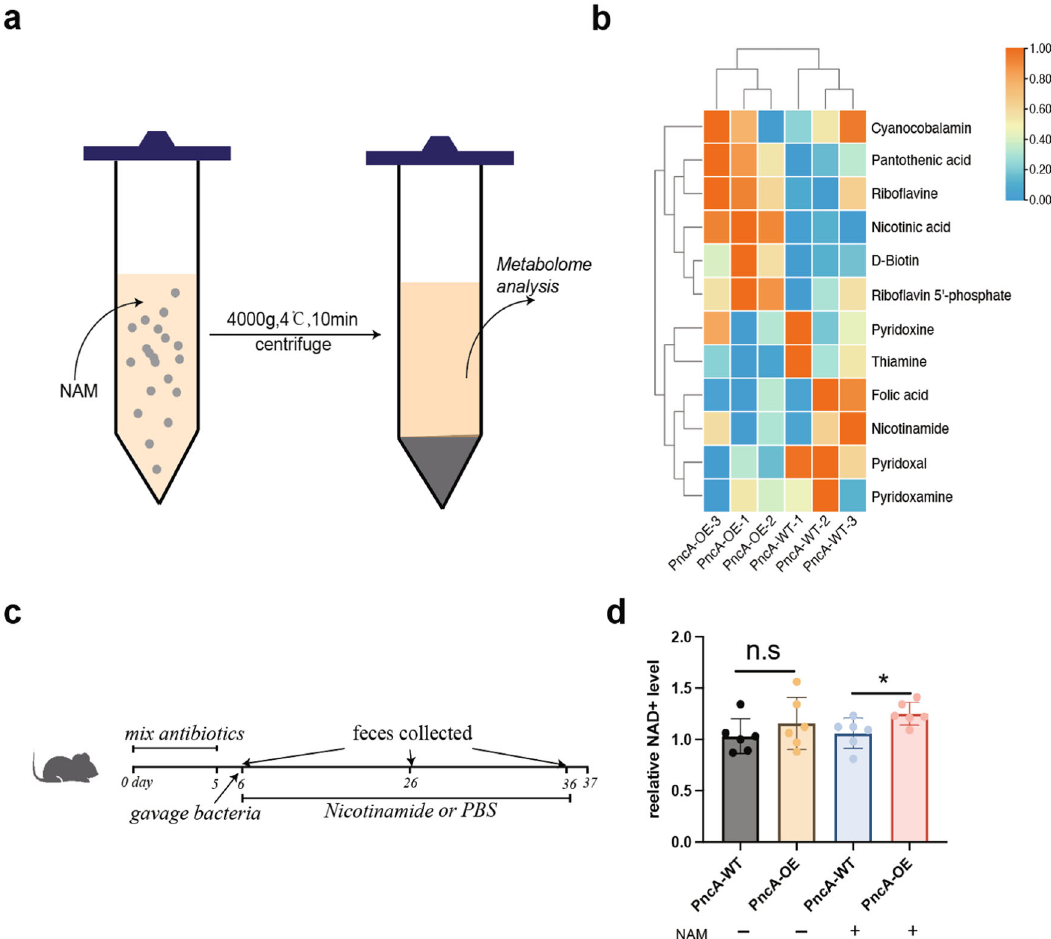
Fig. 3 PncA-overexpressing E. coli affect host liver NAD metabolism. a Schematic diagram of the in vitro experiment (created by Adobe Illustrator). b Heatmap of the metabolites in the bacterial culture medium. c Schematic diagram of the mouse experiment. d Liver NAD + level after colonizing mice with different genotypes of E. coli ( n = 6, * p < 0.05, n.s = no signi fi